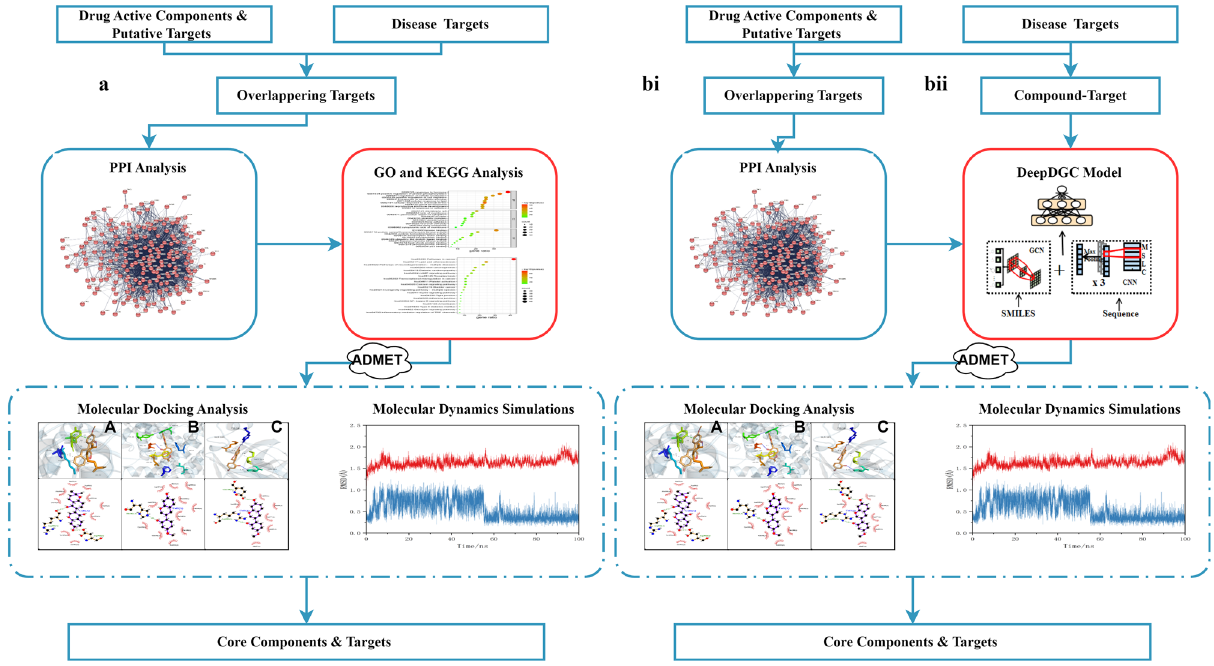
Figure 1. ( a ) Flow chart of traditional network pharmacology process (P1); ( b ) Improved flow chart for two processes: (i) process P2 and (ii) process